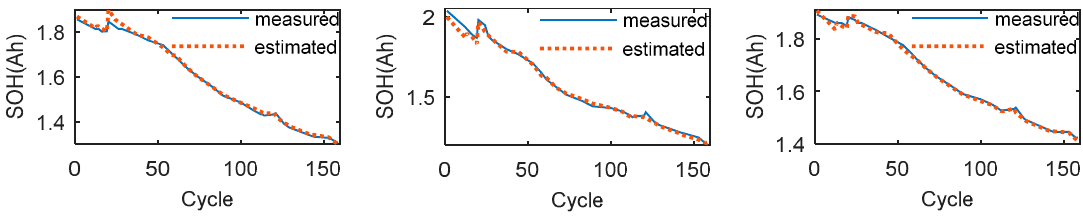
Figure 4. The SOH estimation results of the LS-SVM model with the polynomial kernel tested on the No.5, No.6 and the No.7 batteries.